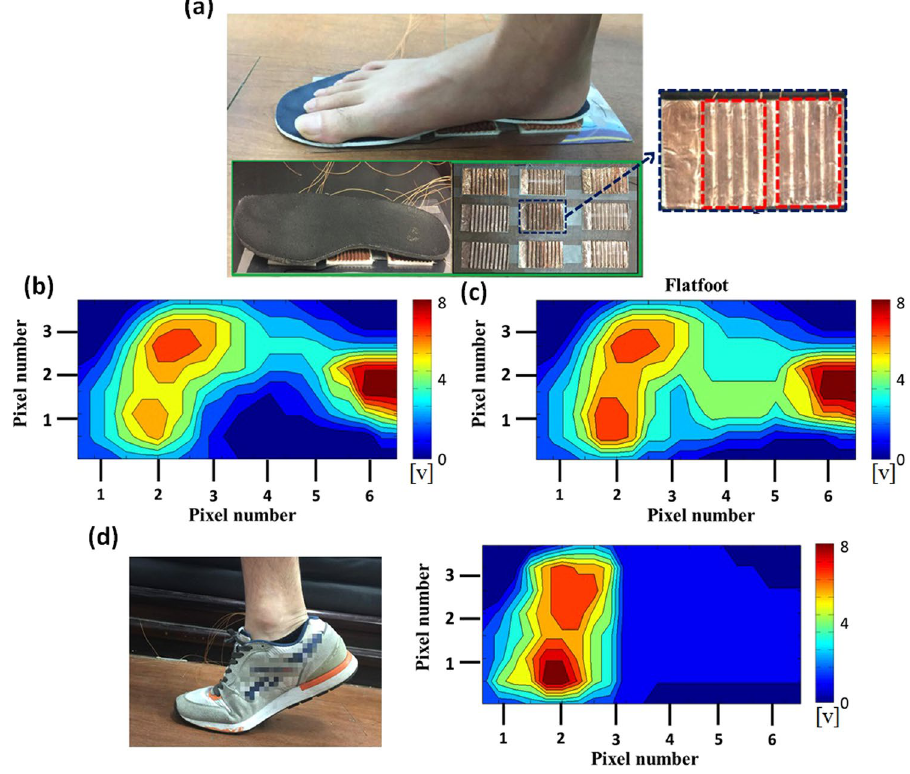
Figure 5. ( a ) Actual demonstration of WSS integrated self-powered foot pressure sensor arrays (3 × 3; 4.5 cm × 3 cm of dimension for each unit cell) for detecting the foot pressure (inset: visually illustrated insole on top of the foot pressure sensor device). ( b ) and ( c ) shows two dimensional contour plot mapping of pressure potential from the objects of ( b ) normal foot, ( c ) flat foot. ( d ) In a tip-toed position and the related two dimensional contours plot mapping of pressure